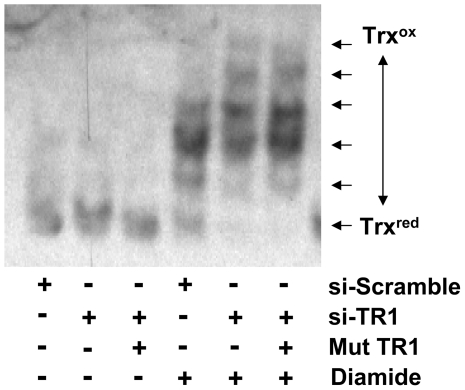
Evaluation of the 6 possible redox states of Trx.In cells without stimulation (left three lanes), Trx is primarily in the reduced state, even with TR1 knocked-down and the C-terminal mutant TR1 expressed. With 1 mM diamide stimulation for 30 min (right three lanes), cells with endogenous TR1 demonstrate more reduced Trx than cells with endogenous TR1 knocked-down with siRNA.